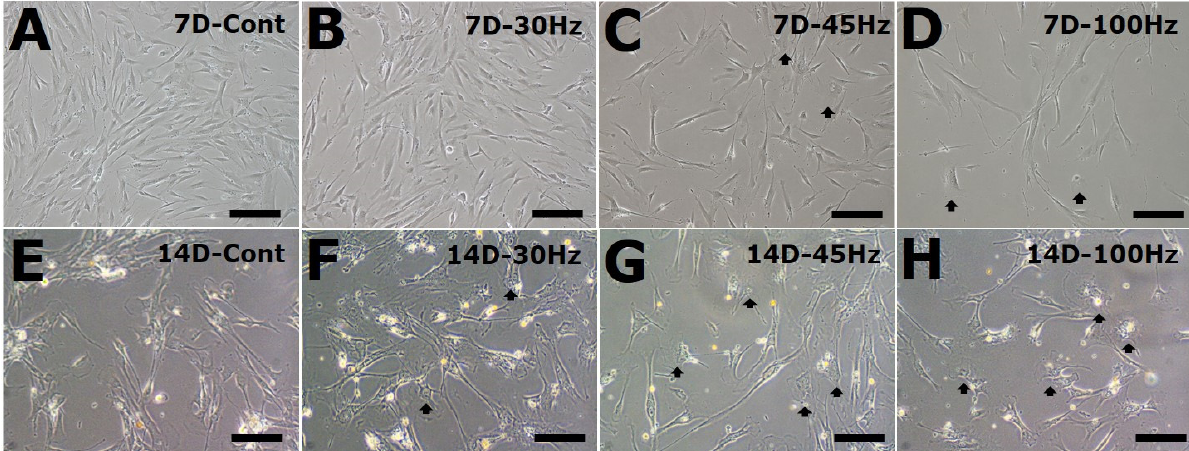
Figure 2. The morphology of human dental pulp stem cells (HDPSCs) subjected to mechanical vibration for 7 D ( A – D ) or 14 D ( E – G ). Some of the HDPSCs in the vibrated groups assumed a cuboidal shape ( F – H ). Black arrows indicating differentiated cells. ( A ) No mechanical vibration (control), ( B ) 30 Hz, ( C ) 45 Hz, ( D ) 100 Hz mechanical vibration. Original magnification; ( A – D ) 100×, ( E – H ) 200×; Scale bar: ( A – D ) 200 μ m, ( E – H ) 100 μ m.